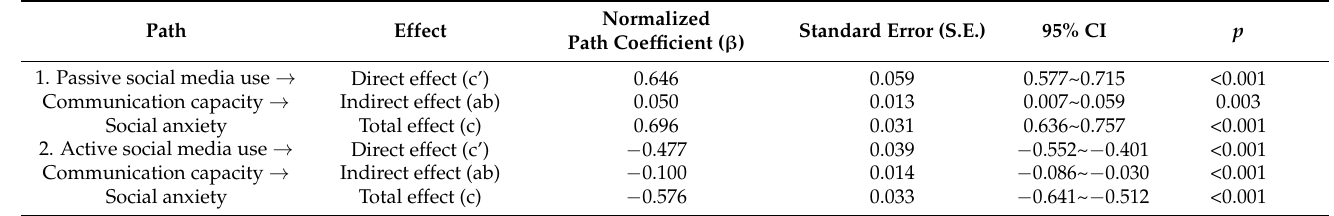
Table 4. Bootstrap analysis of the mediating effect of communication ability between social media use and social